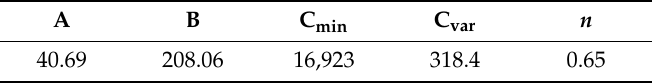
Table 2. Coe ffi cients for pipes and storm tank cost curves.